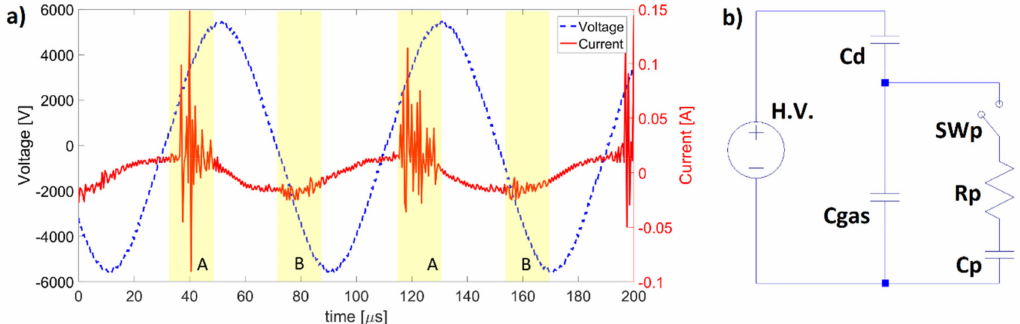
Figure 2. Dielectric barrier discharges (DBDs): ( a ) voltage–current time behavior and ( b ) equivalent electrical